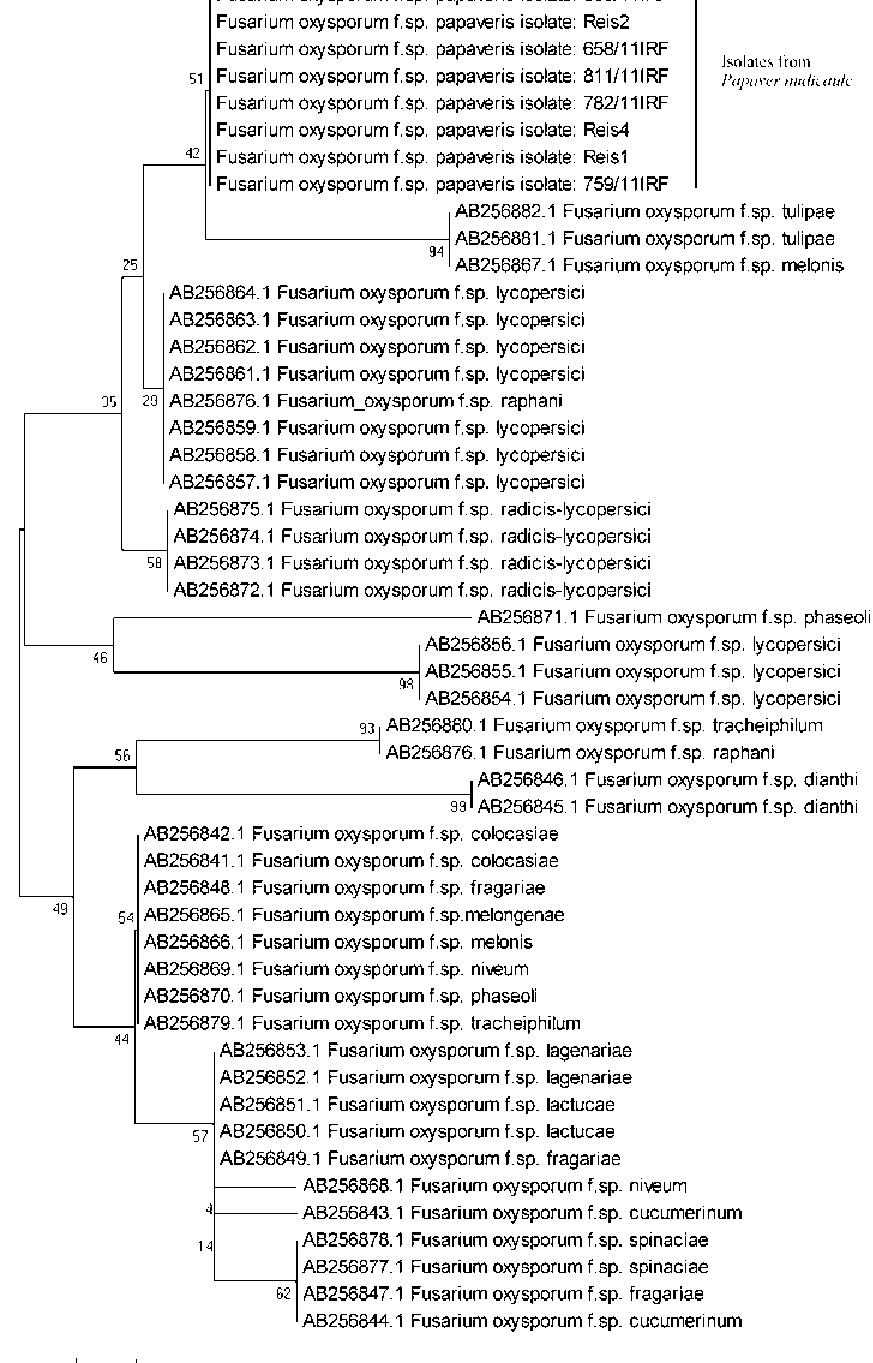
Figure 3. Phylogenetic tree based on Pg5 gene sequences built by Mega5 software with Neighbor joining method; bootstrap values from 1000 replicates are shown at the